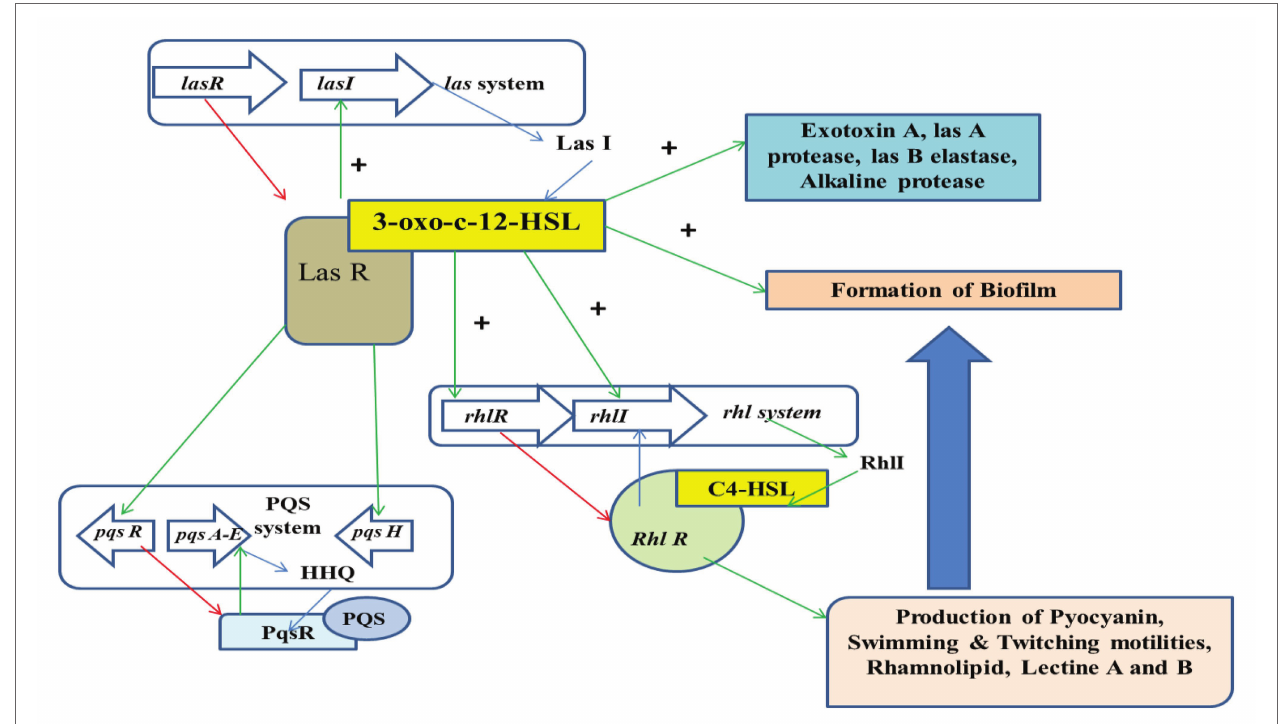
FIGURE 2 | Regulation of the mechanism of